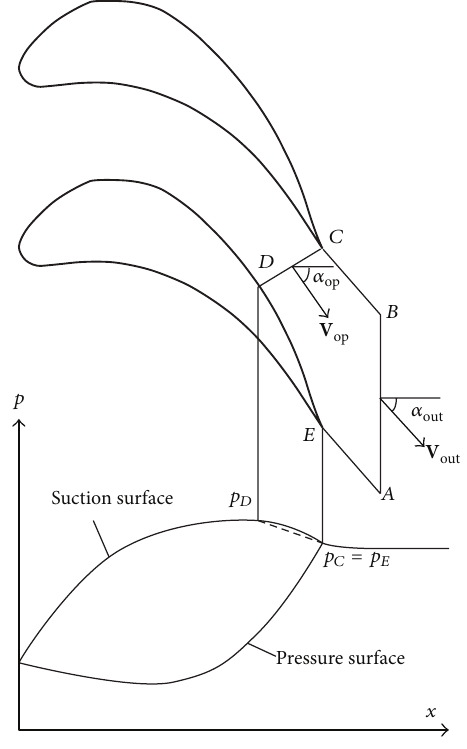
Figure 4: Control volume.